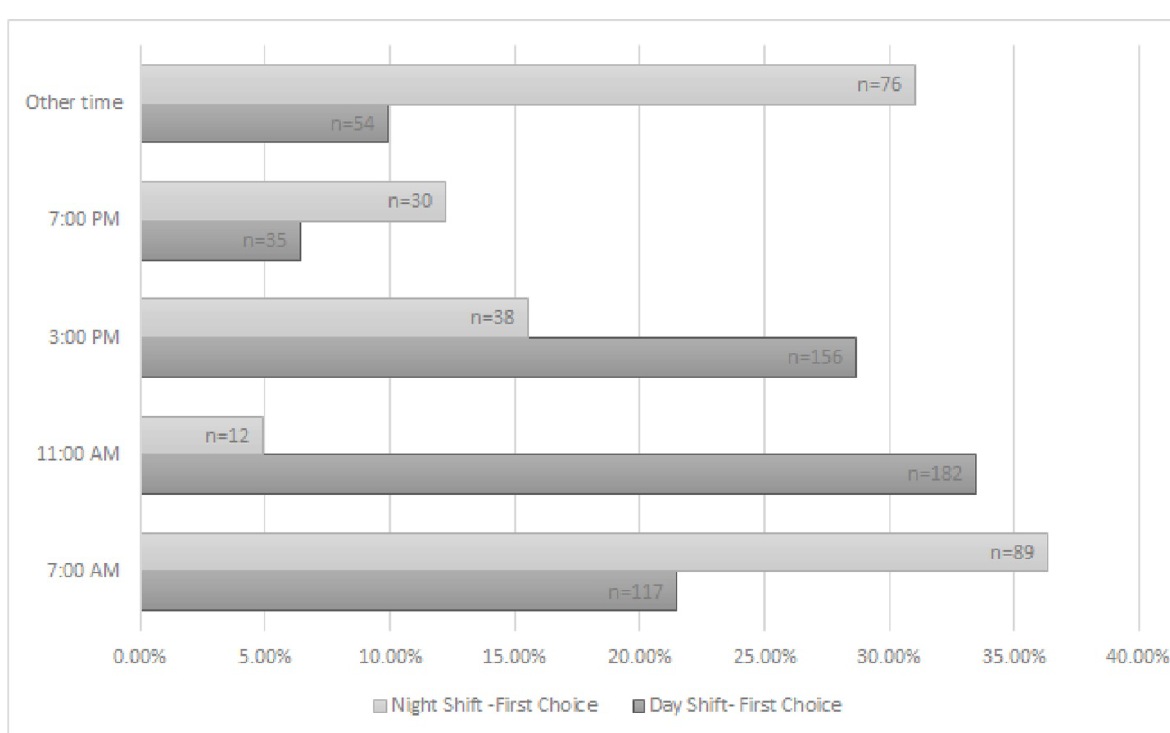
Figure 2 Preference for time of day to attend an educational offering (first